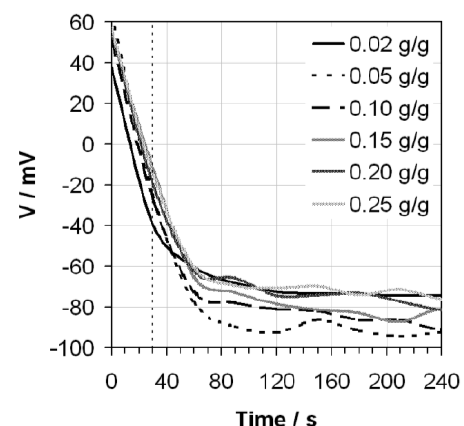
Figure 2. Voltage (V) exhibited by the glass electrode as a function of time when measuring ethanol containing varying mass fractions of water (as indicated by the legend) using the ASTM D6423 method. The ASTM D6423 specified measurement time is also indicated (vertical dotted